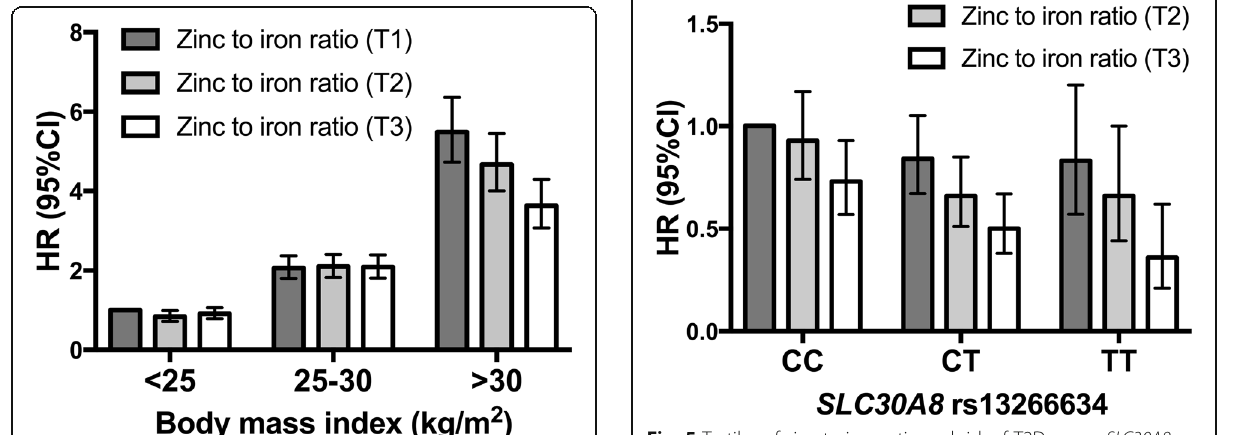
Fig. 5 Tertiles of zinc to iron ratio and risk of T2D across SLC30A8 rs13266634 genotype among obese subjects in the MDCS ( n = 2550). Hazard ratios (HR) from a Cox proportional hazards model adjusting for dietary and non-dietary confounders. P three-way interaction (zinc to iron ratio × BMI × genotype) =